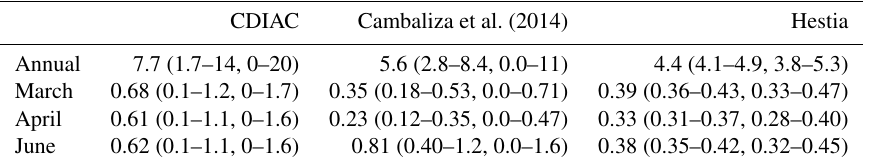
Table 3. Comparison of INFLUX airplane-based results, Hestia, and the CDIAC 1 ◦ × 1 ◦ map. All values reported in Tg C. Reported in parentheses are 1 σ and 2 σ mass ranges. Cambaliza et al. (2014) report airplane-based results for 1 March, 29 April, and 1 June 2011 of 11000, 7500, and 26000mols − 1 , respectively. Unit conversion equate these values to 4.2, 2.8, and 9.8Tg Cyr − 1 . The 5.6Tg C average is reported above. For monthly samples, a similar unit conversion was completed. For both annual and monthly cases, the Cambaliza et al. and Hestia results were scaled up to the temporal resolution of the CDIAC data.